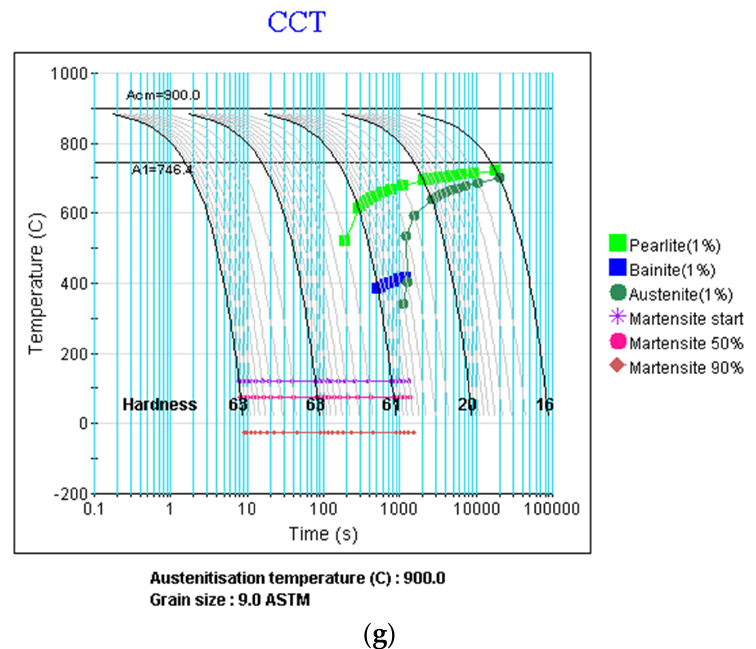
Figure 9. GCr15 thermal physical properties and mechanical properties: ( a ) thermal conductivity; ( b ) coefficient of thermal expansion; ( c ) specific heat; ( d ) Poisson’s ratio and Young’s modulus; ( e ) yield stress; ( f ) hardening parameter; ( g ) continuous cooling curve of GCr15.